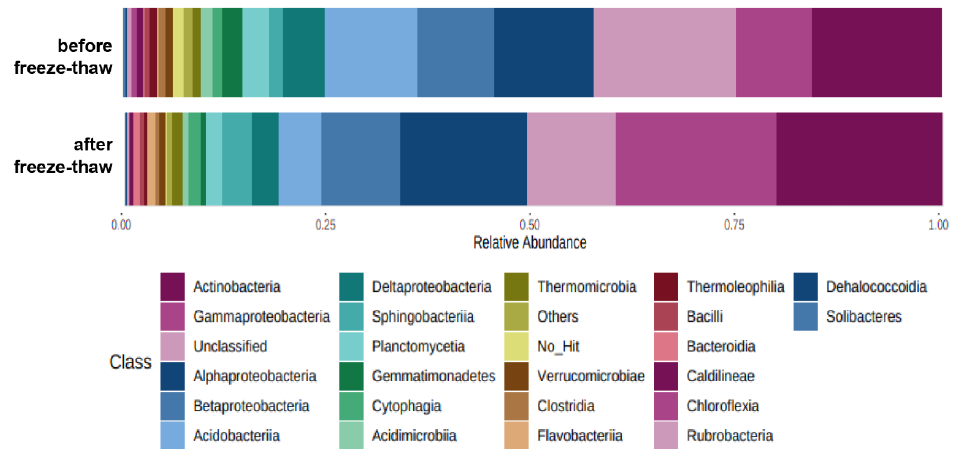
Figure 7. A stacked bar graph presenting microbial composition at a class level of soil samples, (relative percentage abundance of particular sequences among all obtained sequences), 25 most abundant taxa presented, samples were merged to groups by freeze–thaw after completed phytostabilization under the following conditions: (1) greenhouse temperatures (before freeze–thaw) and (2) greenhouse temperatures, followed by FT-chamber temperatures (after freeze–thaw).